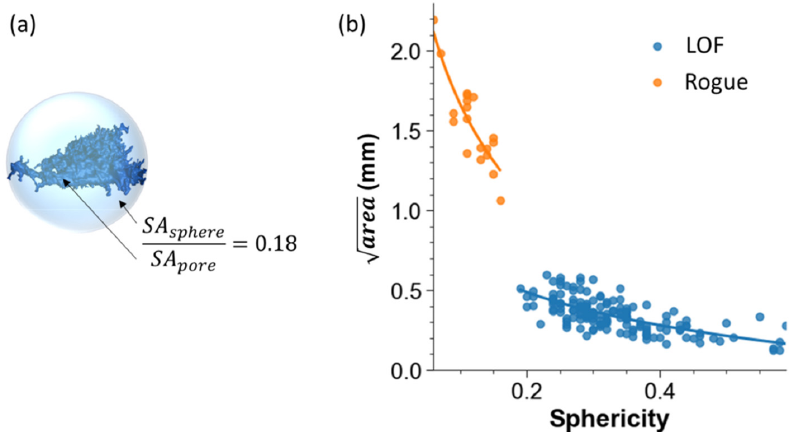
Figure 9. Sphericity of internal pores and voids. ( a ) Example of a LOF defect and the calculated sphericity according to Equation (3). ( b ) Pore size distribution in terms of the √𝑎𝑟𝑒𝑎 as a function of sphericity. Note the separation of the rogue and LOF defects.